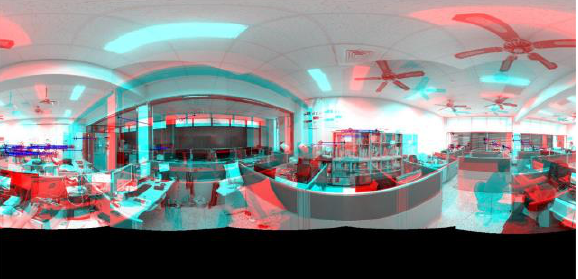
Figure 9(a). Movement test with affine model